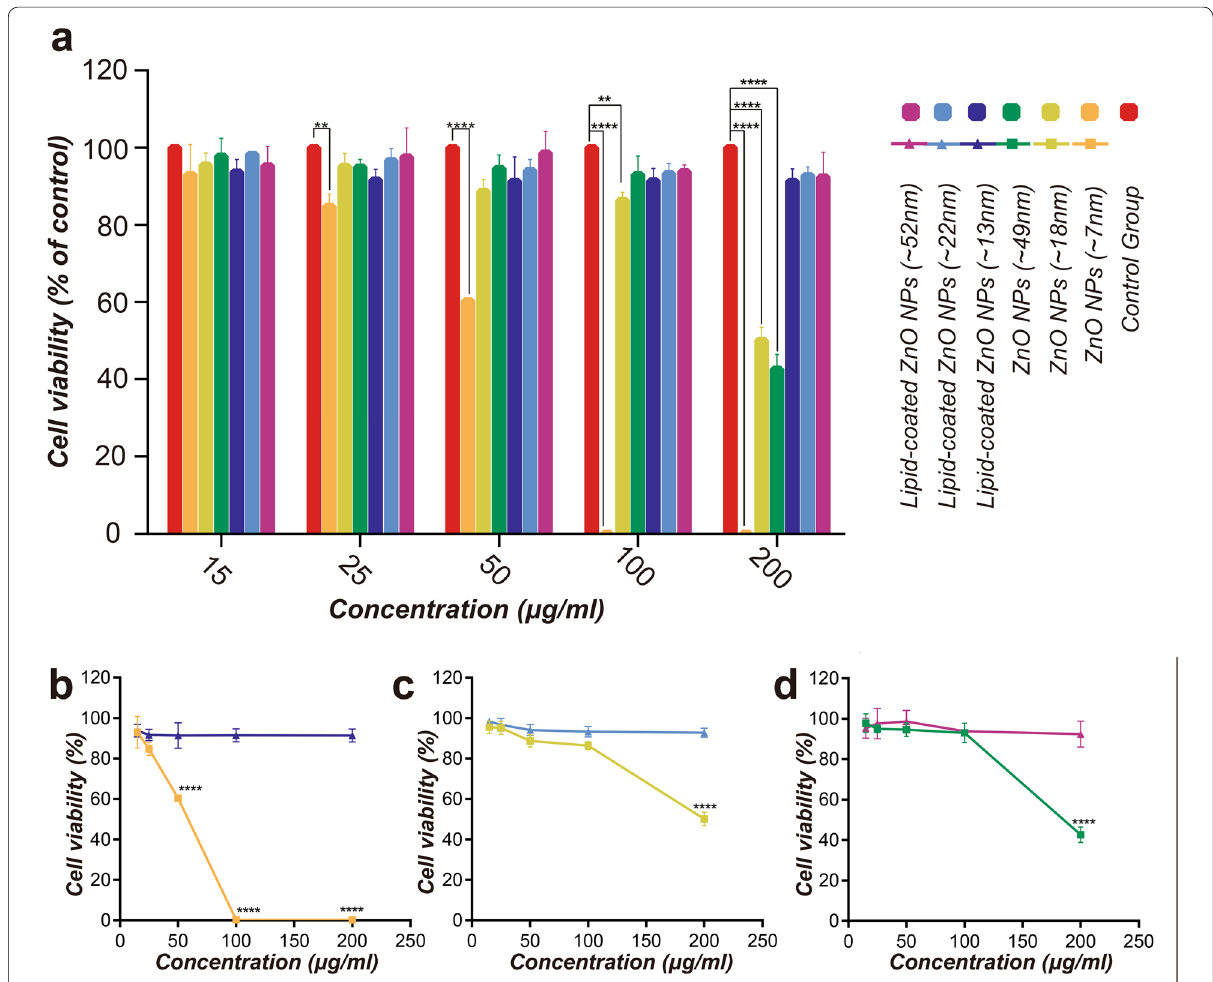
Fig. 9 The cell viability of HeLa cells after 24 h of exposure to ZnO and lipid-coated ZnO NPs. a Control group vs ZnO NPs (~ 7 nm; ~ 18 nm; ~ 49 nm) and lipid-coated ZnO NPs (~ 13 nm; ~ 22 nm; ~ 52 nm); b ZnO NPs (~ 7 nm) vs lipid-coated ZnO NPs (~ 13 nm); c ZnO NPs (~ 18 nm) vs lipid-coated ZnO NPs (~ 22 nm); d ZnO NPs (~ 49 nm) vs lipid-coated ZnO NPs (~ 52 nm). The activity was measured with CCK-8 assay, and the data were expressed as mean SD (standard deviation) of three experiments. *p < 0.05, **p < 0.01, ***p < 0.001, ****p < ±